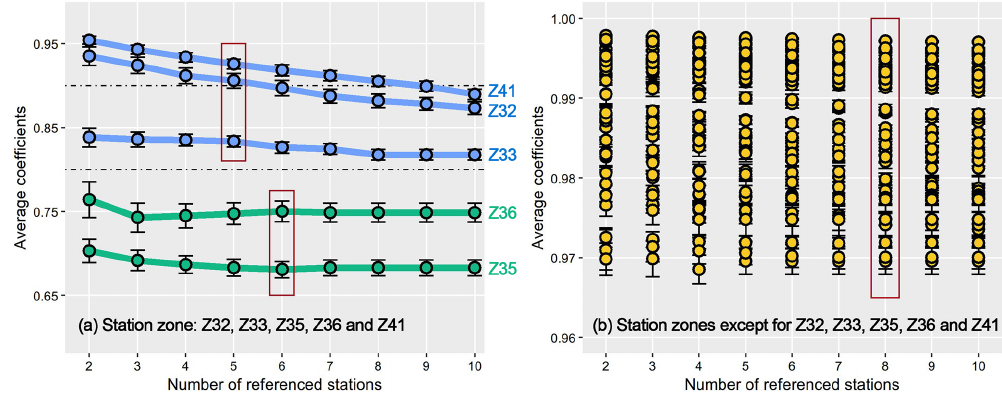
Figure 3. Average correlation coefficients between series of candidate and reference stations in different station zones. The red box highlights the number of maximum reference stations which was used for